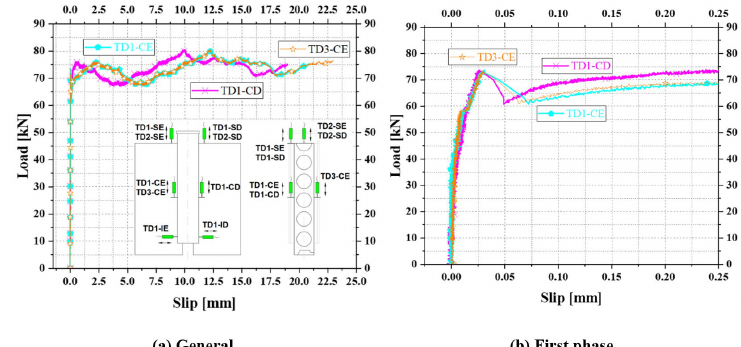
Fig. 11: Load versus slip curves at the half length of the